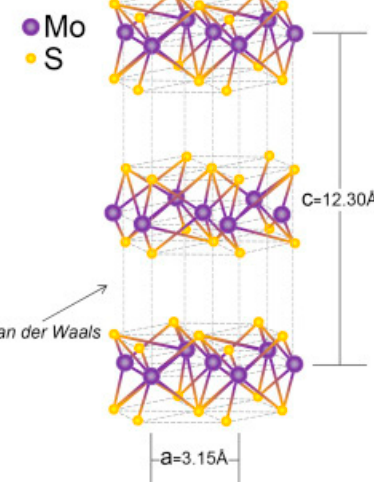
Figure 12. Schematic diagram for the structure of MoS 2 [93] .